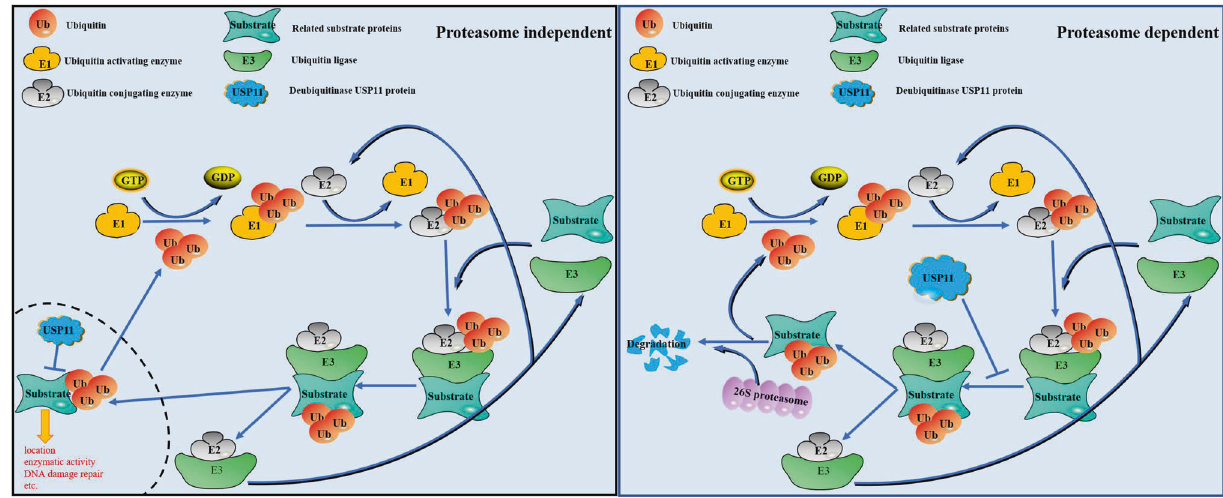
Fig. 1 The fl ow chart of ubiquitination and the mechanism of ubiquitination inhibition by USP11. Left panel: proteasome-independent manner, ubiquitin is activated by E1 and attaches to E1, which is further transferred to E2 and forms a new complex. The entire complex then binds to the E3 substrate complex to form a complete ubiquitination complex, and E3 eventually transfers the ubiquitin molecule to the substrate protein. USP11 further cleavages ubiquitin chain from substrate protein (such as lys63- and lys6-linked ubiquitin chain), eventually contributed to the change of substrate protein function and location etc. not degradation; right panel: proteasome-dependent manner, ubiquitin is activated by E1 and attaches to E1, which is further transferred to E2 and forms a new complex. The entire complex then binds to the E3 substrate complex to form a complete ubiquitination complex, and E3 eventually transfers the ubiquitin molecule to the substrate protein, where the substrate bound ubiquitin further recruit proteases for substrate degradation. USP11 signi fi cantly inhibits substrate protein degradation (usually lys48-linked ubiquitin chain)).